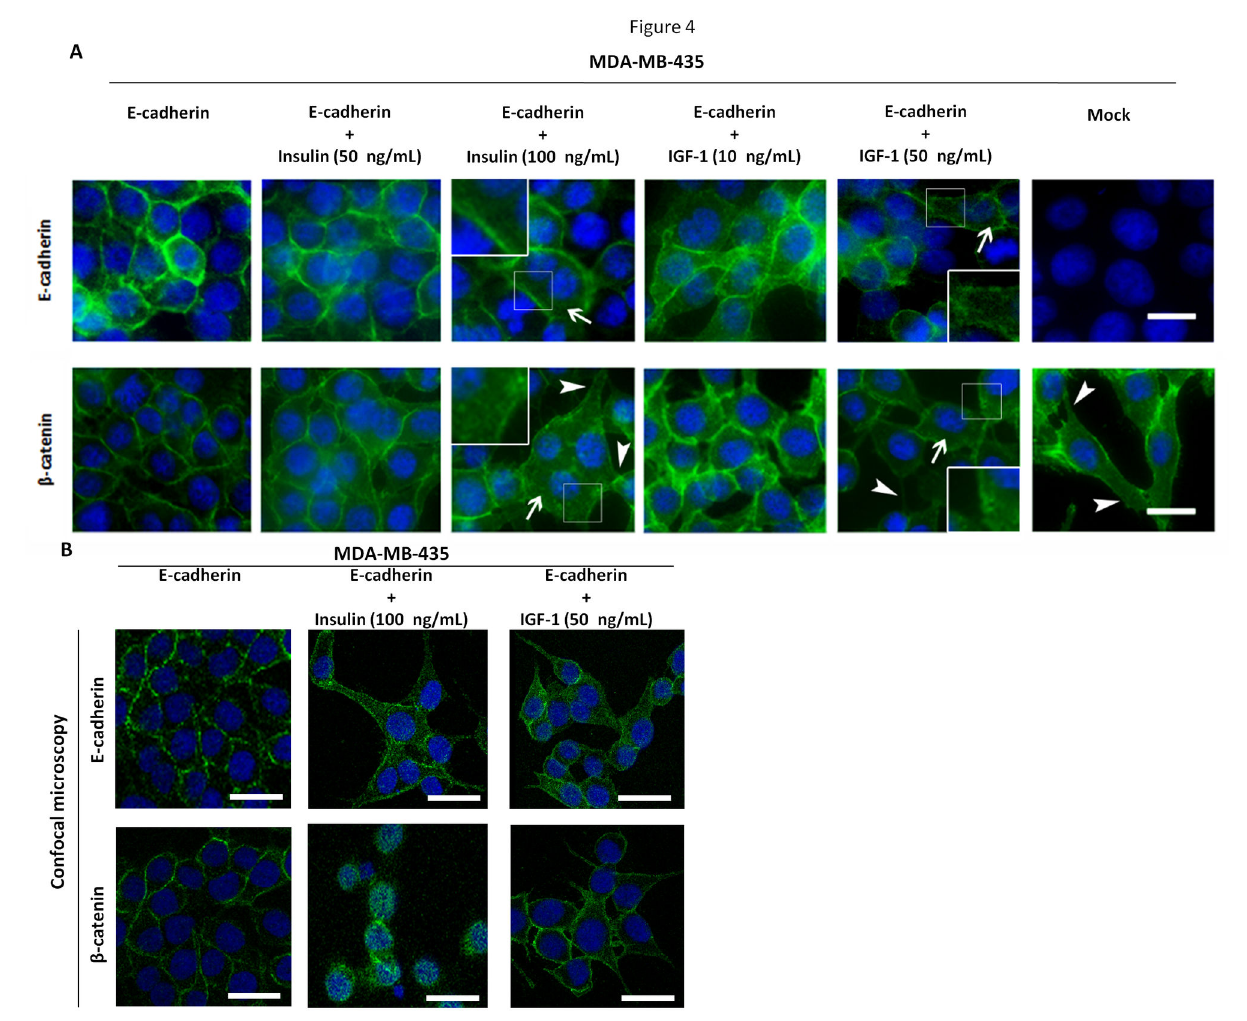
Figure 4. Subcellular localization of E-cadherin and β-catenin after stimulation with insulin and IGF-I. (A) Cell monolayers from MDA-MB-435+mock, MDA-MB-435+E-cad and MDA-MB-435+E-cad stimulated (24h) with insulin or IGF-1 were fixed and stained for E-cadherin, β-catenin and nucleus (DAPI). Diffuse cytoplasmic expression levels of β-catenin and E-cadherin are observed (arrows) after stimulation with insulin or IGF-I, together with observation of cytoplasmic protusions compatible with a fibroblastoid-like appearance (arrowheads). The representative images were obtained by fluorescence microscopy. White arrows and magnified images indicate cytoplasmic staining. Bar = 10 µm. (B) Confocal microscopy showing the cytoplasmic staining of E- cadherin and β-catenin after stimulation with insulin and IGF-I. Bar = 10 µm. doi: